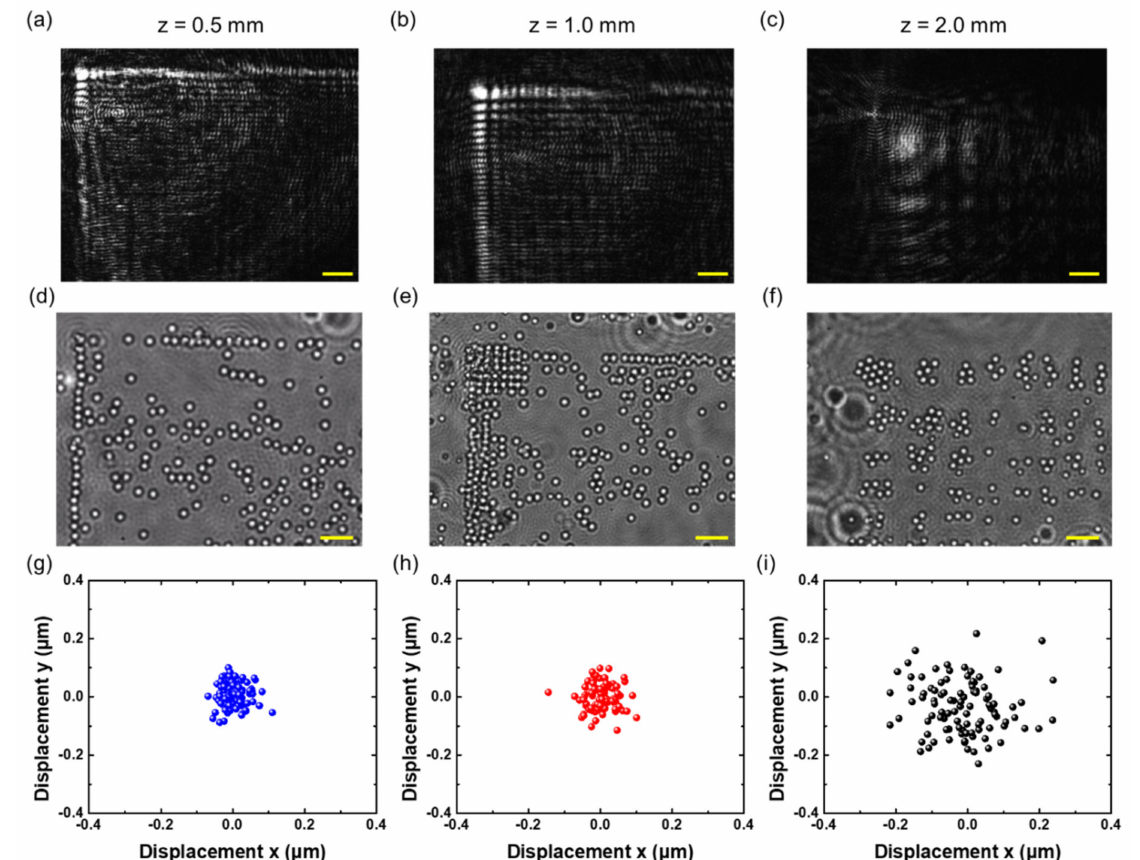
Figure 5. Optical trapping dynamics of microspheres based on a vertically accelerated 2D Airy beam generated by the cubic-phase metasurface. The intensity distribution of the vertically accelerated Airy beam in water along the propagation direction at ( a ) z = 0.5 mm, ( b ) 1.0 mm and ( c ) 2.0 mm, respectively. ( d – f ) After illuminating the focused beam, the corresponding distribution of microspheres appears at different depths. Scale bar: 6 µ m. ( g – i ) Displacement of the captured microspheres around the main lobe of the Airy beam in x- and y- direction at different propagation depths with a measurement duration of 15